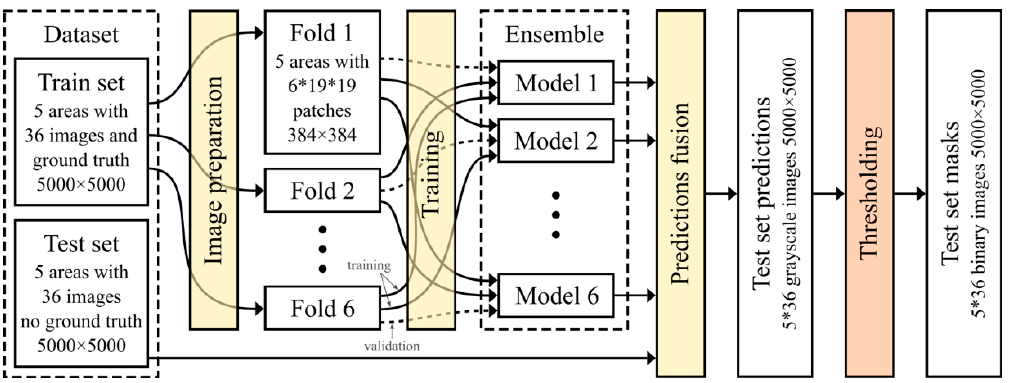
Figure 2. Illustration of the proposed processing pipeline applied to the Inria dataset.